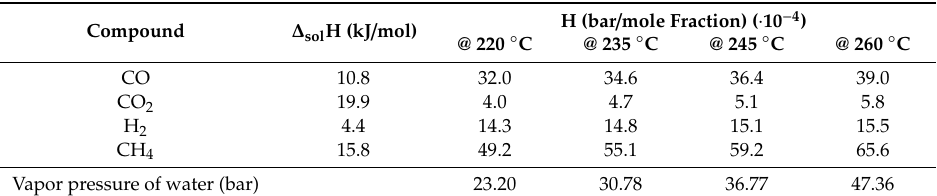
Table 6. Estimated H values and vapor pressure of